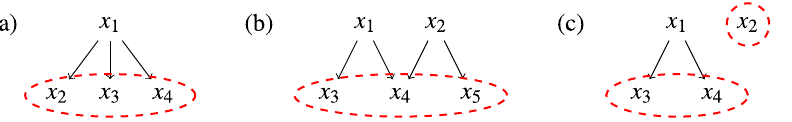
Figure 2. Dilation examples which illustrate the need for updated definitions including Dilation Delta, Minimal Dilation, and Dilation Choice Set. Important dilations are circled sets of